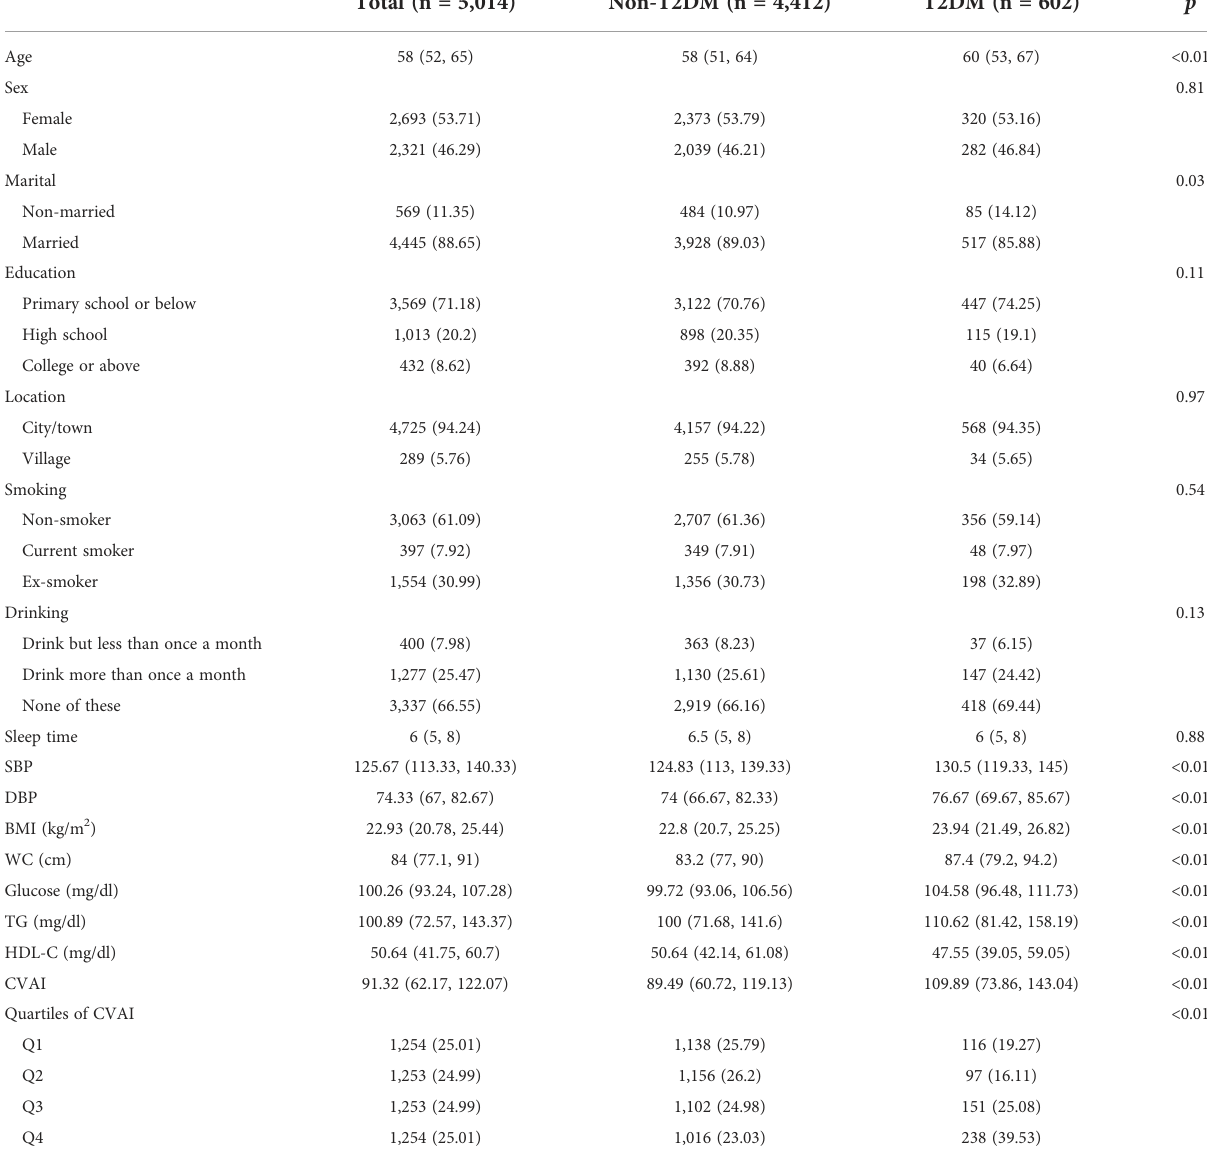
TABLE 1 Characteristics of the participants at baseline (N =